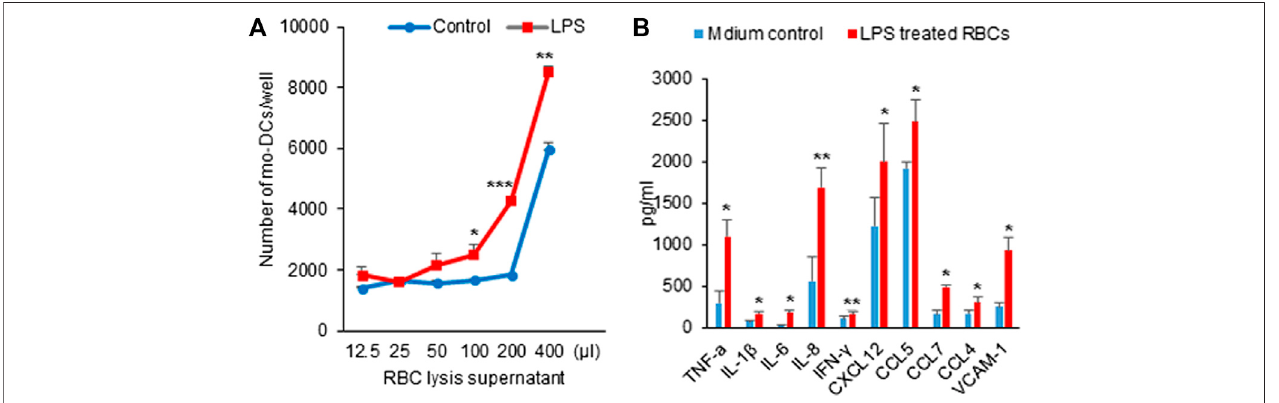
FIGURE 3 | ( A ) Hemolysis by LPS induced mo-DCs migration. After overnight incubation with mo-DCs, the number of cells was counted by microscopy. L-sup inducedmo-DCsmigrationinaconcentration-dependentmanner(* p < 0.05,** p < 0.01,*** p < 0.001 vs. therespectivecontrols).Datawererepresentativeofmean ± SD of three experiments. (B) Detection of the cytokine and chemokine levels by ELISA. The cytokines (TNF- α , IL-1 β , IL-6, IL-8, and INF- γ ), chemokines (CXCL12, CCL5, CCL7, and CCL4), and VCAM-1 were signi fi cantly increased at L-sup (* p < 0.05, ** p < 0.01 vs. their respective controls). Data were representative of mean ± SD from six